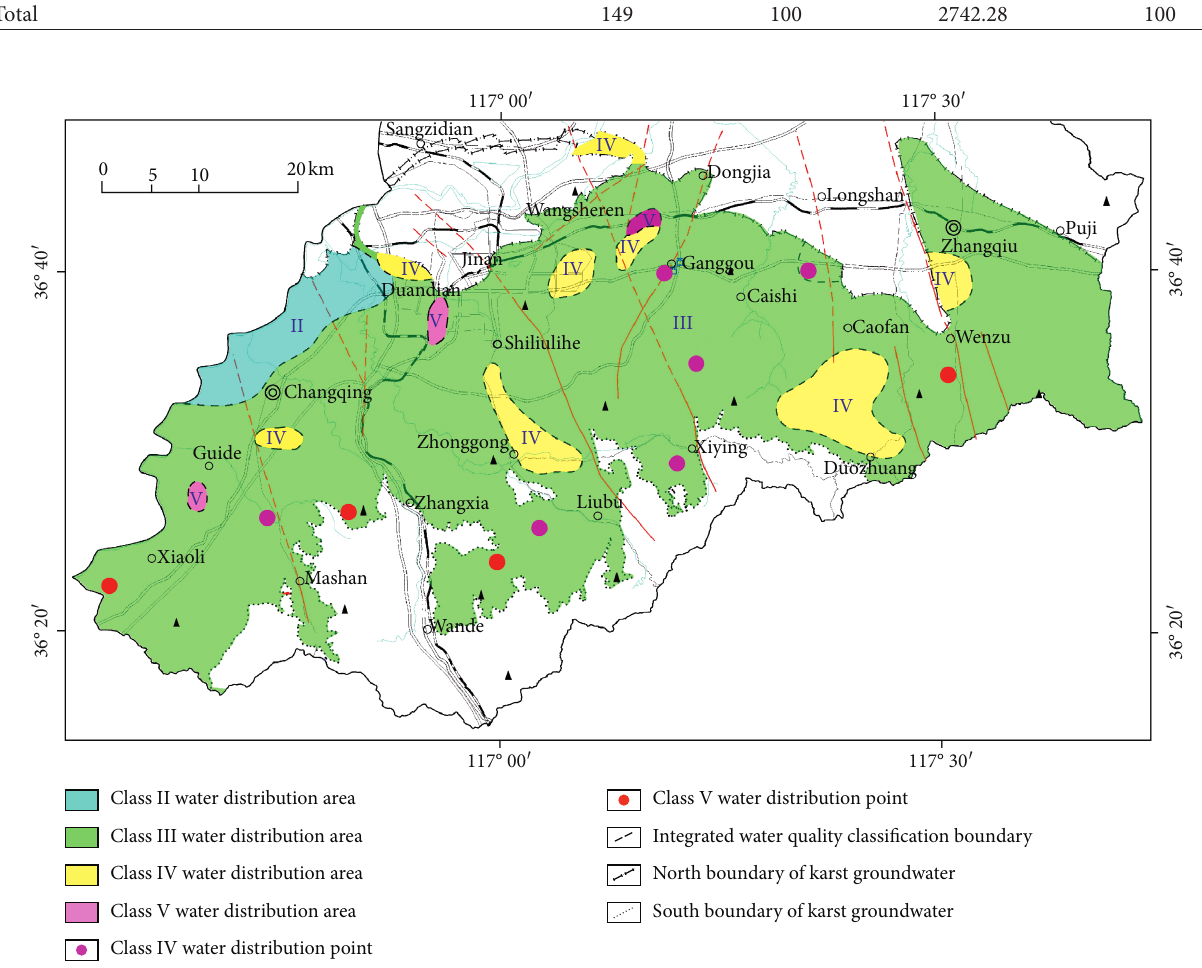
Figure 11: Comprehensive quality distribution of fractured karst